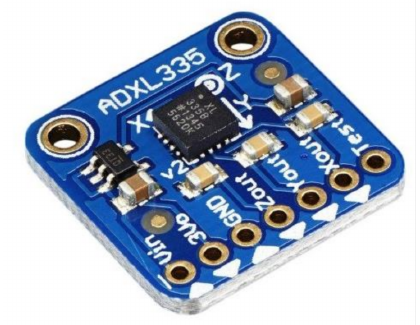
Figure 17. Adafruit ADXL335 (Breakout